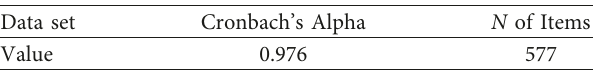
Table 5: Reliability analysis.